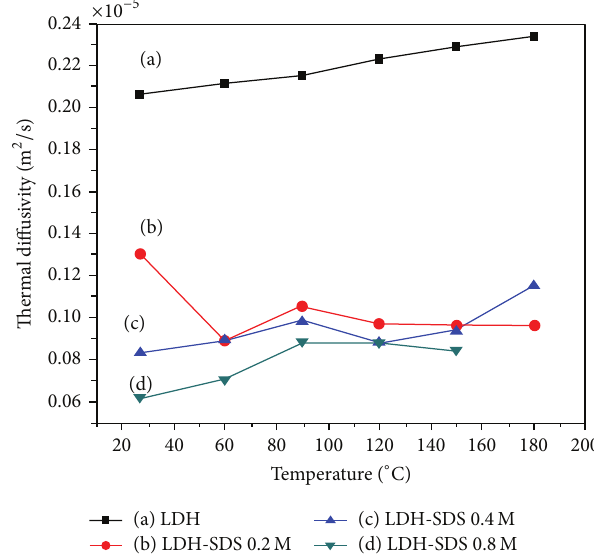
Figure 7: In situ temperature versus thermal diffusivity for Zn4Al- LDH and LDH-SDS in different concentrations of